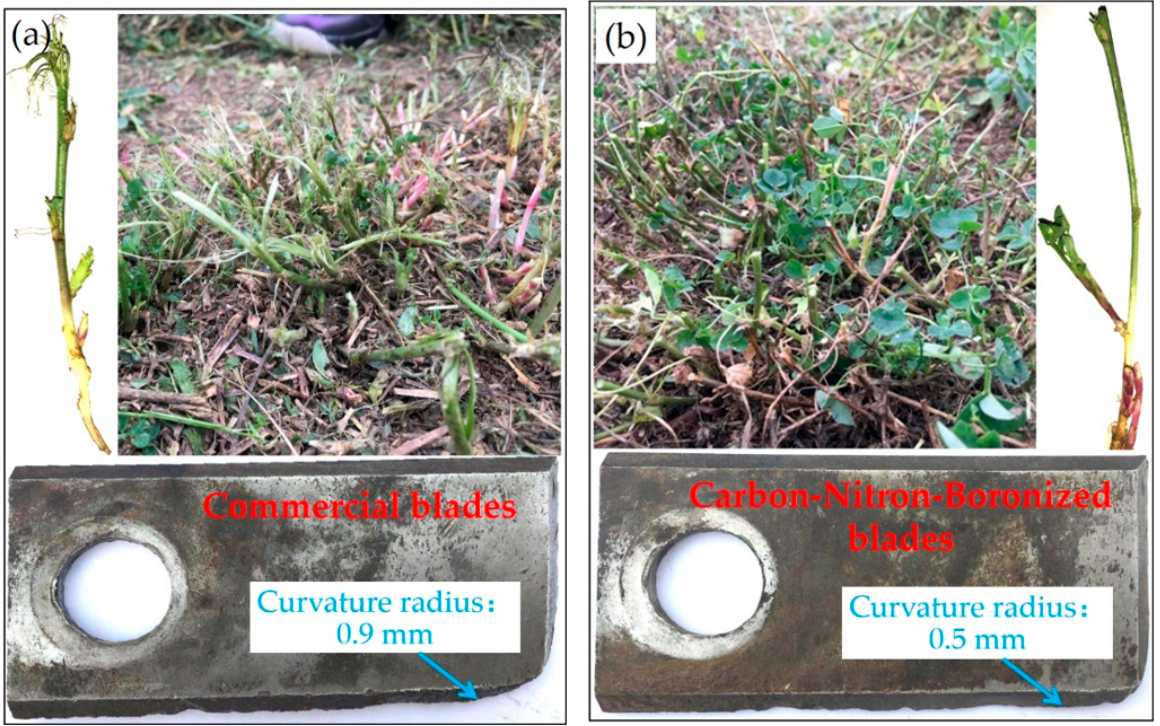
Figure 5. Comparison of macro morphology of the two cutting blades and the cutting incision after 32 h of operation: ( a ) wear morphology of commercial blades and Alfalfa incision; ( b ) wear morphology of carbon-nitron-boronized blades and Alfalfa incision.